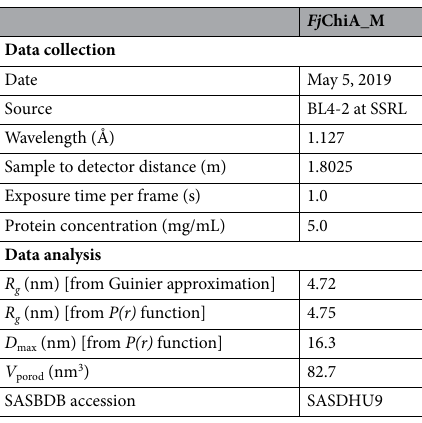
Table 1. SAXS data collection and analysis parameters.